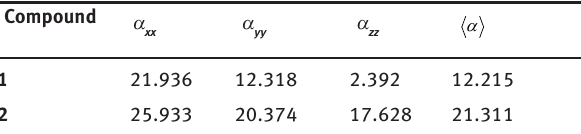
Table 5: Some selected components of the frequency-dependent );( ωωa − and absolute values of );( ωωa − ( × 10 -24 esu) at ω =0.04282 a.u. for 1 - 2 computed by TDHF method with 6-31G( d ) basis set.